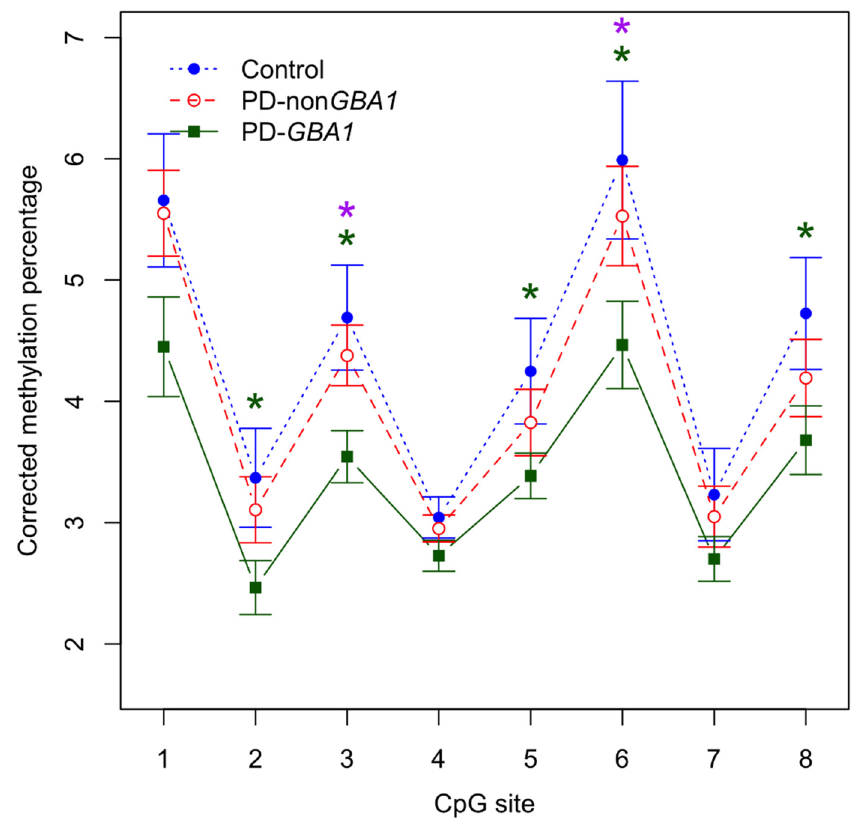
Figure 1. Significant DNA hypomethylation in the frontal cortex in PD- GBA1 . The methylation profile within SNCA intron 1 in the frontal cortex shows a significant decrease (in 5 out of 8 analyzed CpG sites; green stars) for individuals with PD- GBA1 (green) compared to matched controls (blue). DNA methylation was also significantly lower (in 2 out of 8 analyzed CpG sites; purple stars) for individuals with PD- GBA1 (green) compared to idiopathic PD cases (red). n = 11 for PD-non GBA1 , n = 10 for PD- GBA1 , n = 7 for controls. Legend: * = p < 0.05, PD-non GBA1 = idiopathic PD. Error bars–SD. Corrected methylation percentage adjusted for age and gender.